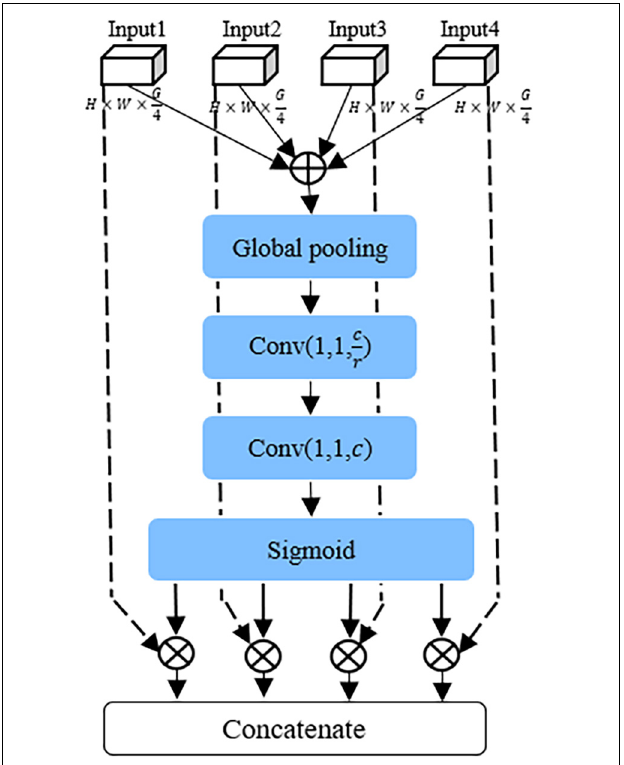
FIGURE 4 | The structure of the cross-scale attention feature fusion module.